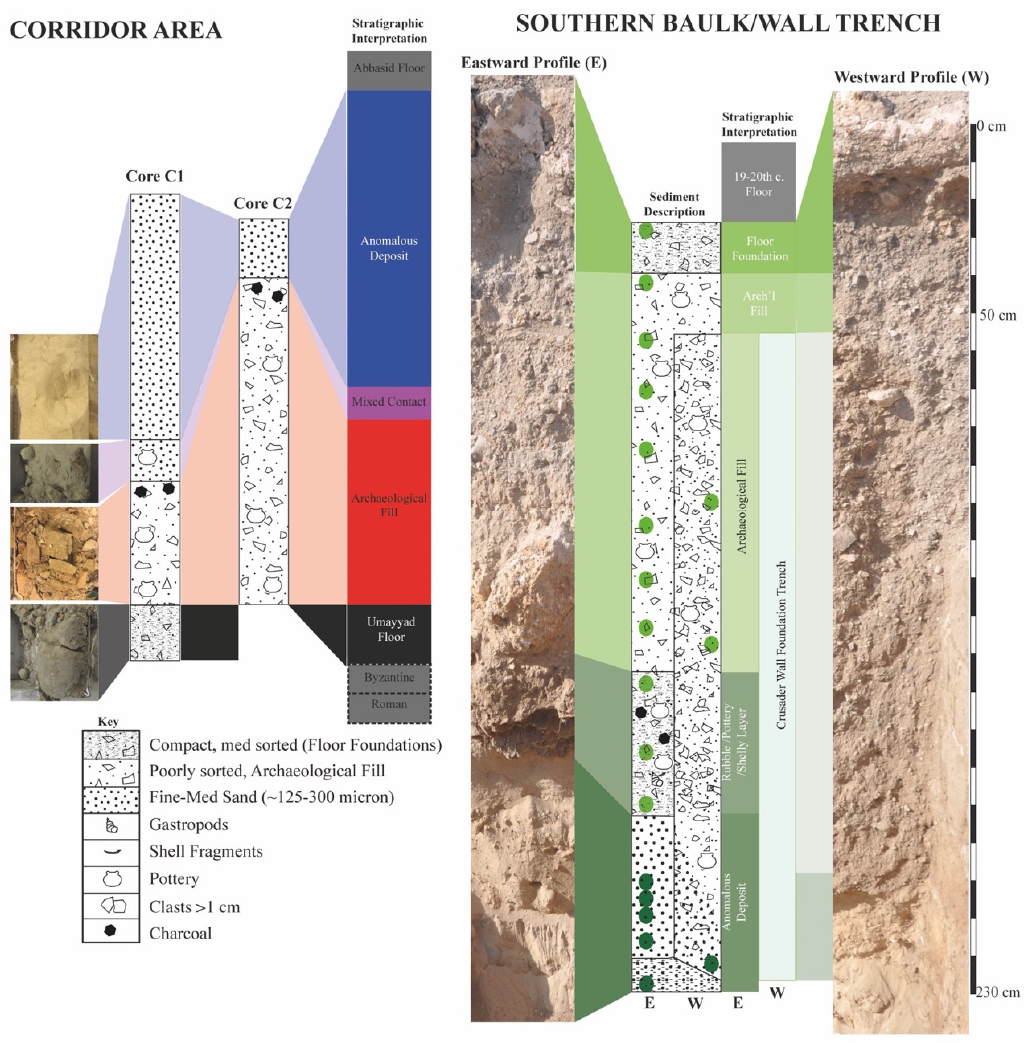
Figure 3. Cores C1 and C2 ( left ) and Southern Baulk section ( right ). Descriptions of all layers identified in cores C1, C2, and the Southern Baulk section.